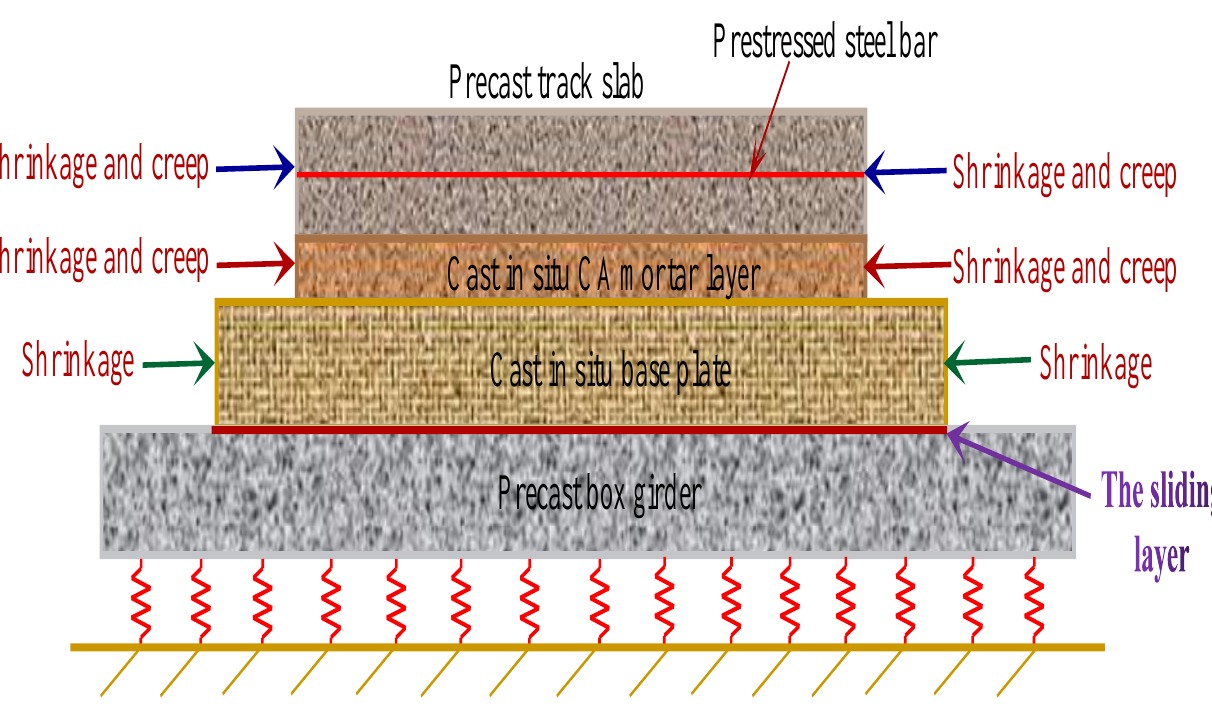
Figure 7. Model of CRTS II slab ballastless track.